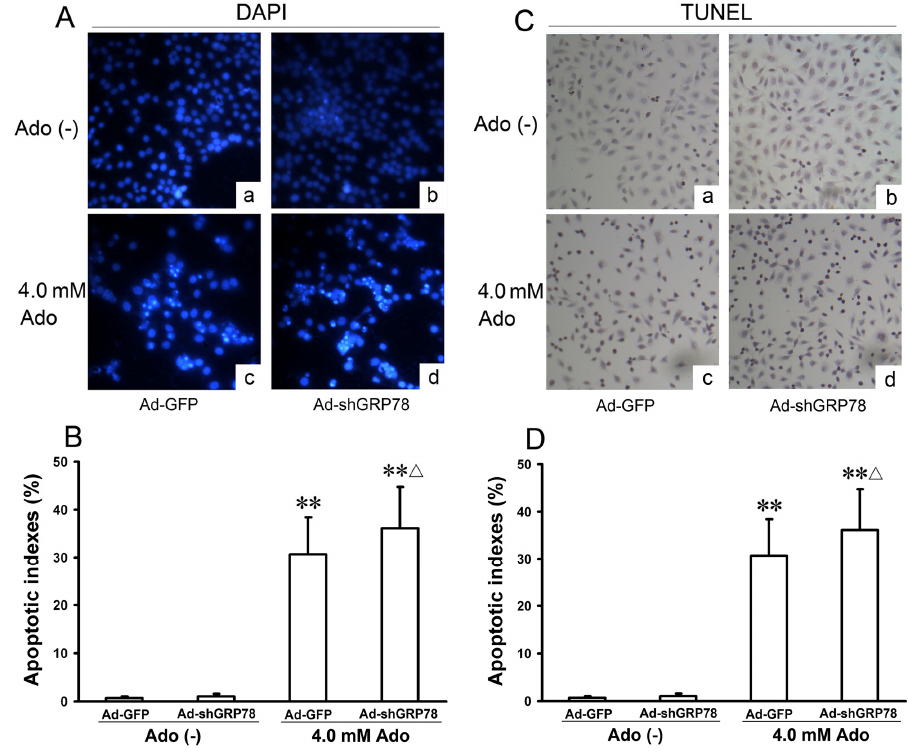
Figure 3. Effects of GRP78 knockdown on adenosine-induced apoptosis in HepG2 cells. HepG2 cells were transfected with either Ad-GFP (control) or Ad-shGRP78. After incubation for 24 h, cells were incubated with or without 4.0 mmol/L adenosine for a further 24 h, then cell apoptosis was examined. The morphology of apoptotic nuclei was observed by DAPI staining and fluorescence microscopy ( A ); Apoptosis was detected by TUNEL assay in HepG2 cells ( C ); The apoptotic fraction was analyzed by flow cytometry. Quantitative analysis of the total apoptotic population is presented. Each bar corresponds to the mean±SD of three independent experiments by above 2 methods ( B , D ). ** p < 0.01, vs. negative control group. Δ p < 0.05, vs. positive control